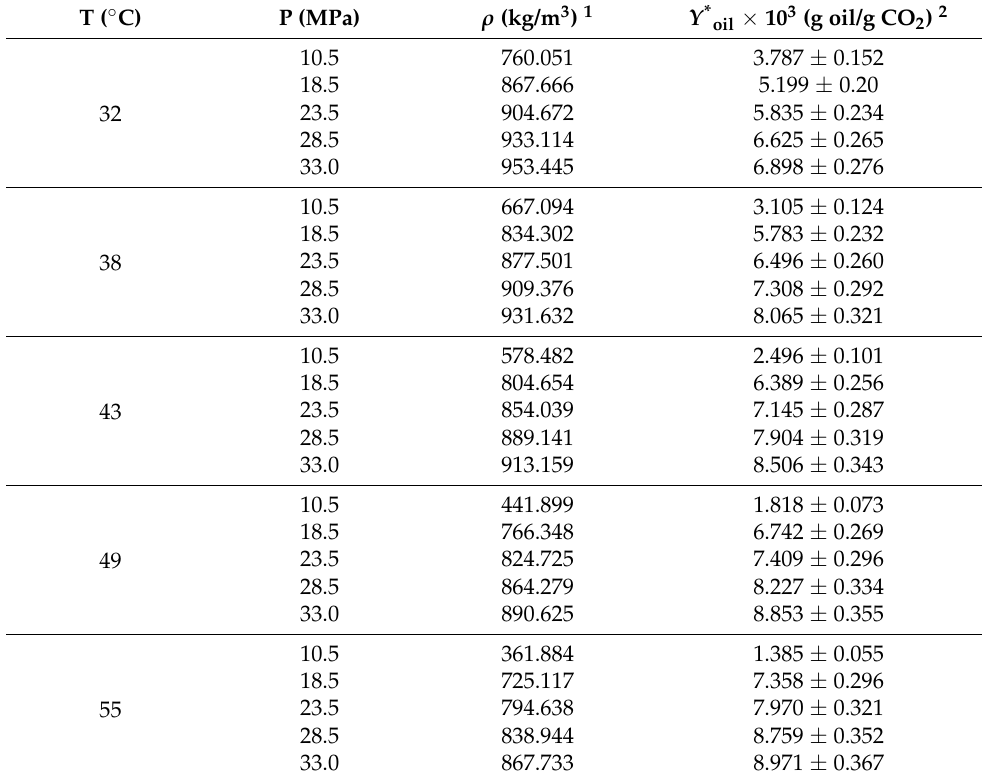
Table 2. Solubility data for the P. frutescens oils obtained by dynamic SC CO 2